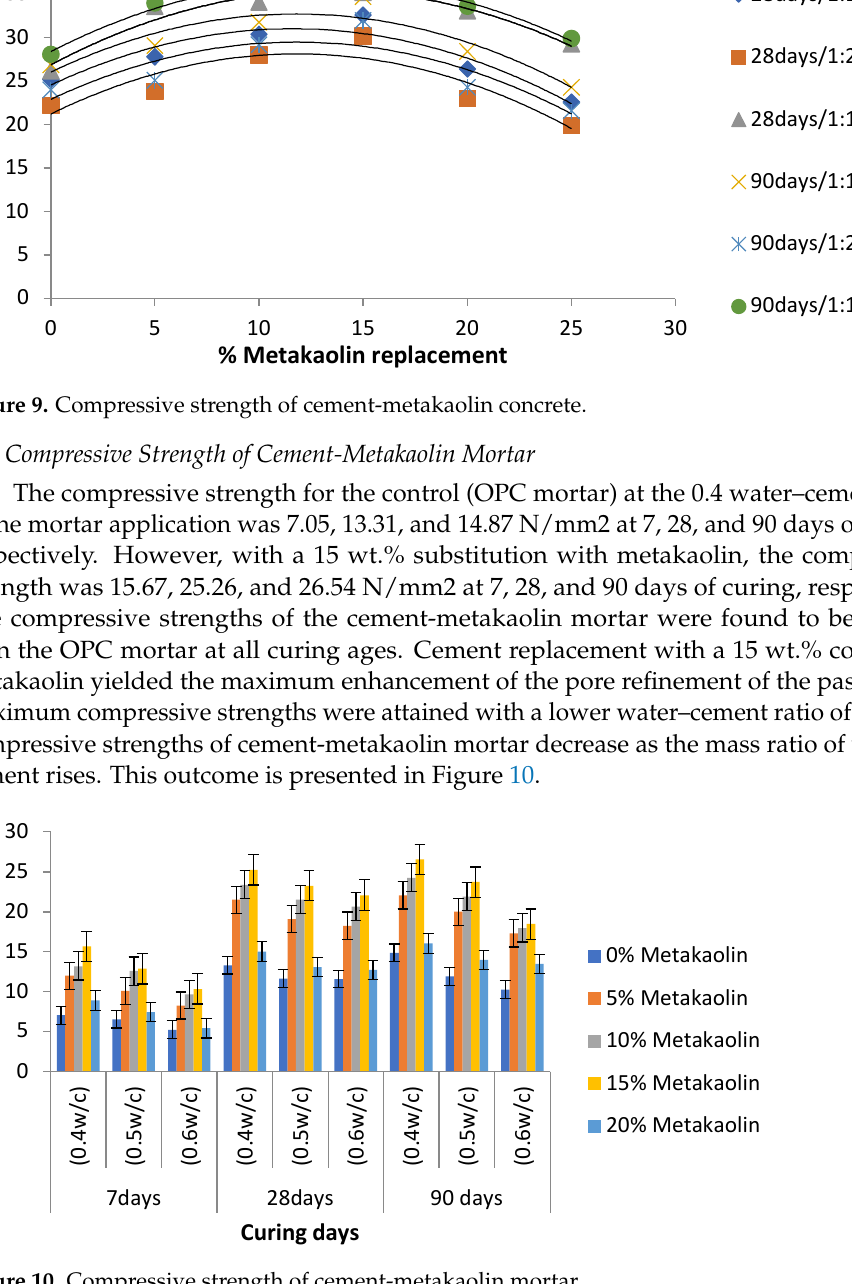
Figure 10. Compressive strength of cement-metakaolin mortar.